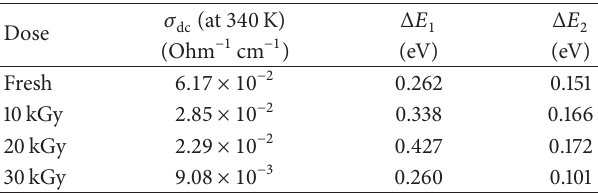
Table 1: The value of radiation dose, dc conductivity ( 𝜎 dc ), and activation energy ( Δ𝐸 1 and Δ𝐸 2